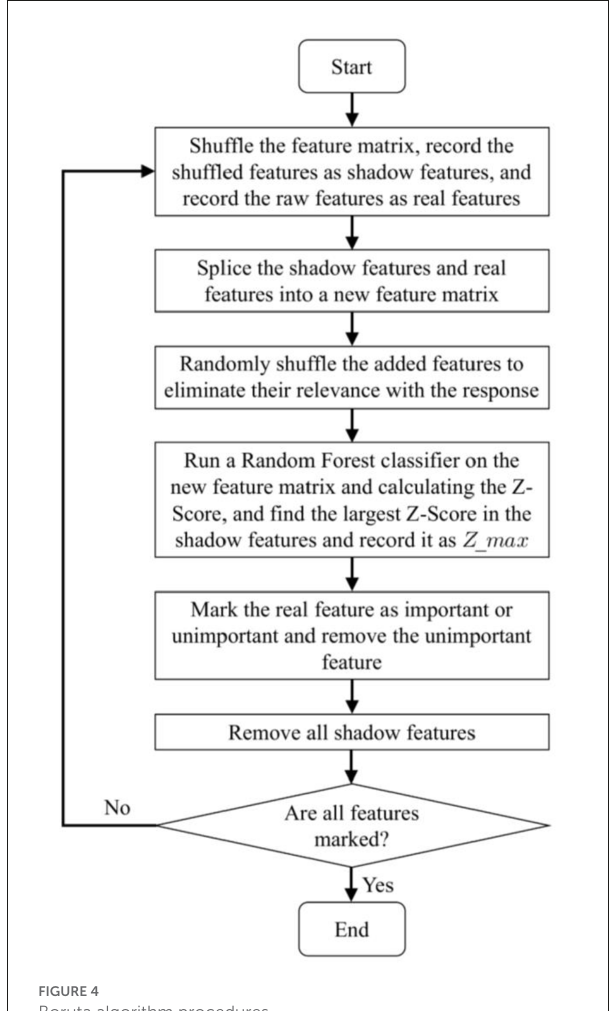
FIGURE4 Boruta algorithm procedures.